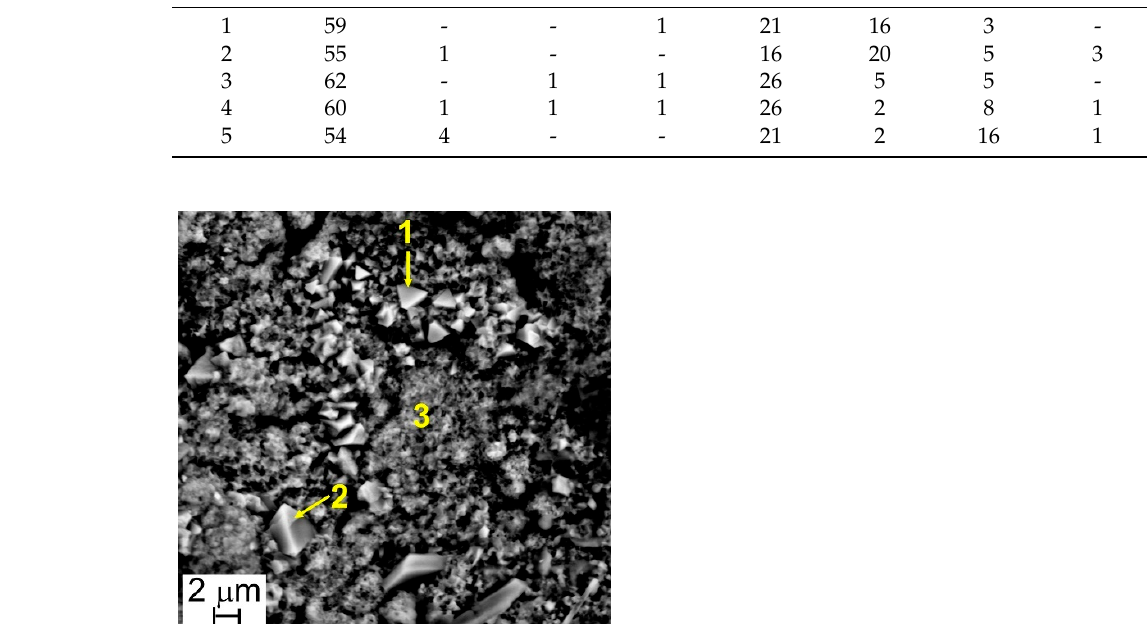
Figure 6. Steel A—SEM-SE micrograph (5000×), and location of Energy Dispersive X-ray Fluores- cence Spectroscopy (EDS) analyses. Table 3. Results of EDS analyses (at.%) performed at points of Figure 6.